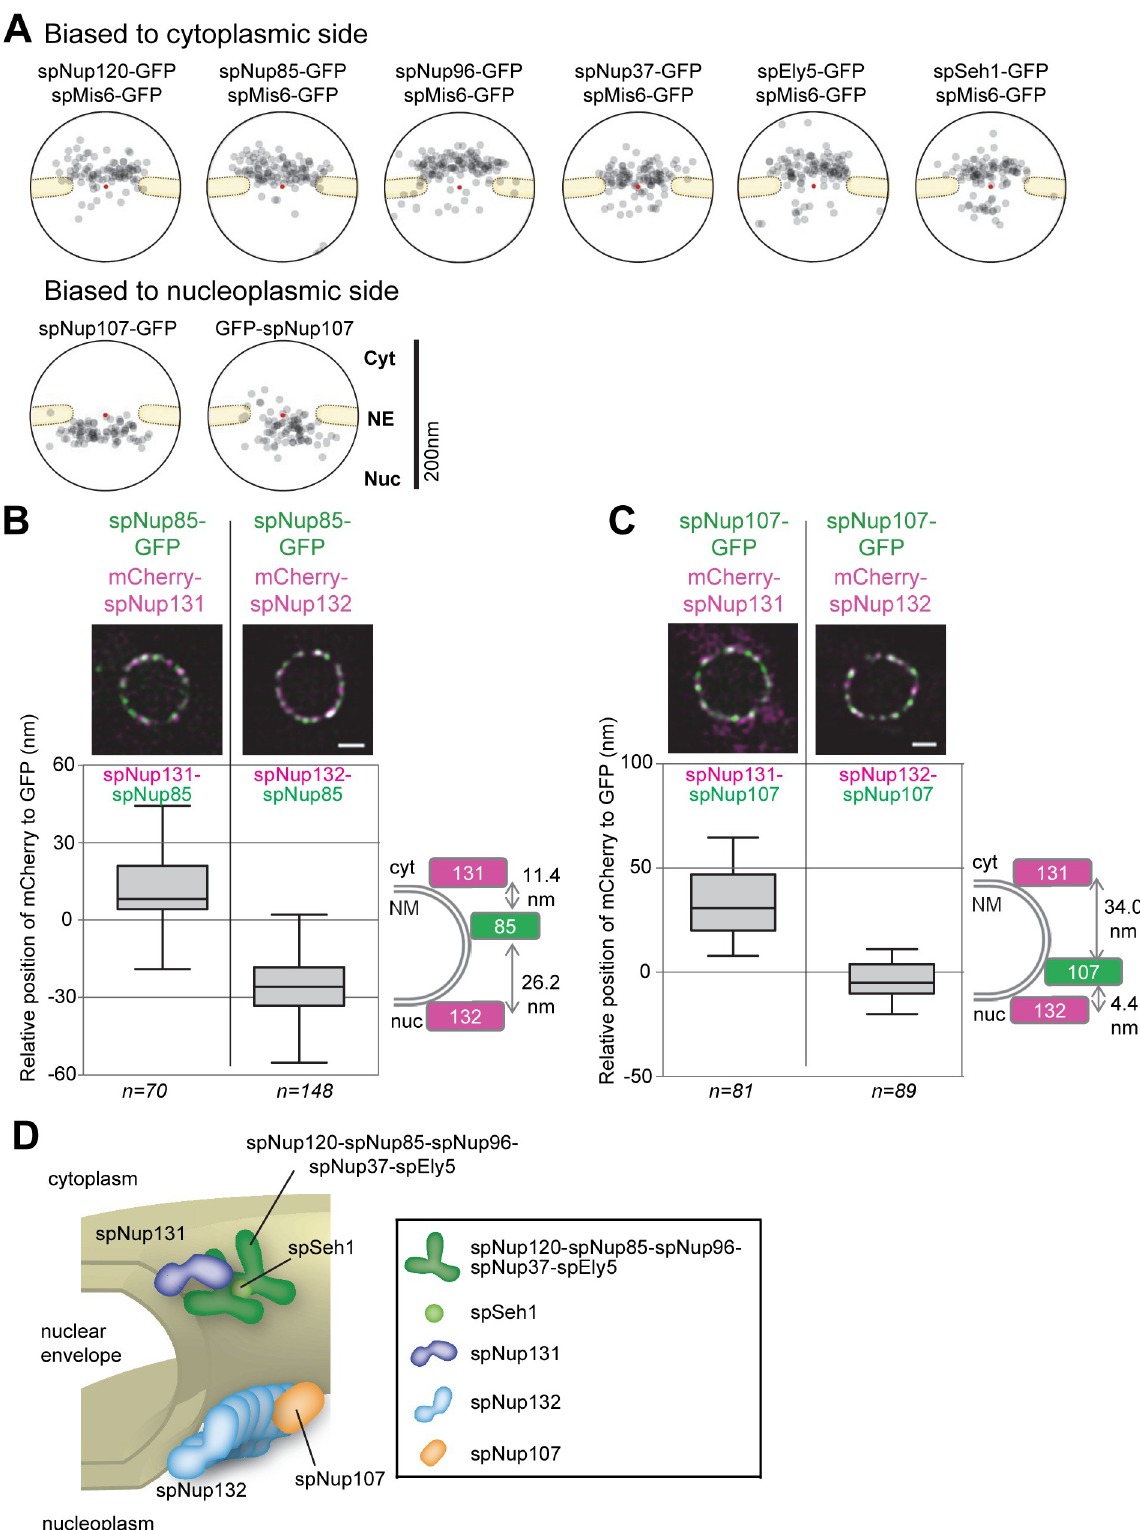
Fig 4. Localization of Nup107-160 subcomplex orthologs. (A) IEM of S . pombe Nup107-160 subcomplex orthologs. Immunogold distributions of the projected immunoelectron micrographs are shown as a quantitative representation. To confirm the accessibility of